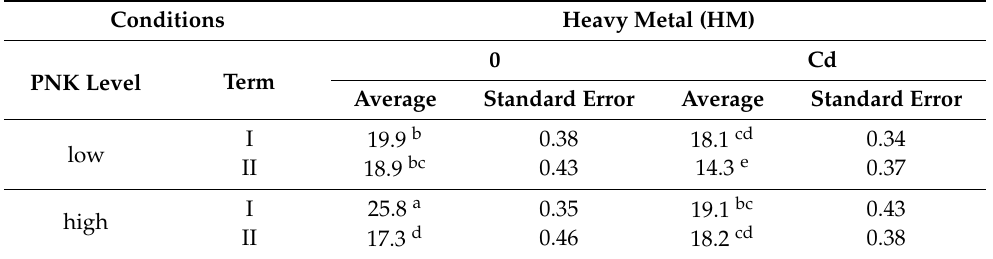
Table 5. The fresh weigh of Hydrocharis morsus-ranae (g) in the three tested growing seasons.